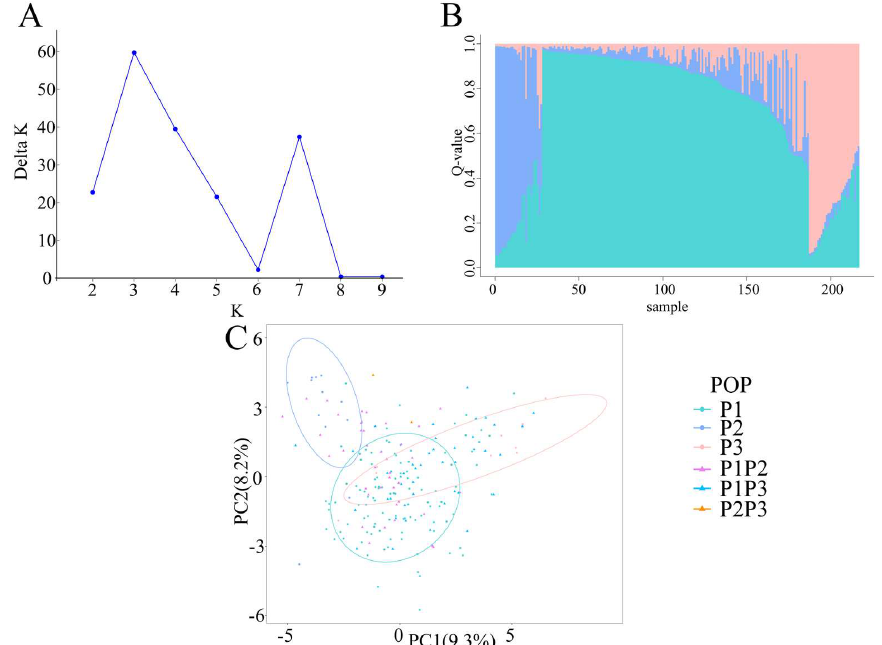
Figure 2. Population structure analysis of 217 radish germplasms. ( A ) ΔK values of different populations. ( B ) Three main subpopulations (P1, P2, and P3) to which 217 radish germplasm resources were assigned. ( C ) Principal component analysis (PCA) of 217 radish accessions. Different subpopulations are exhibited by the different colors: P1, turquoise; P2, cornflower blue; P3, pink; P1P2, purple; P1P3, deep-sky blue; P2P3, orange.